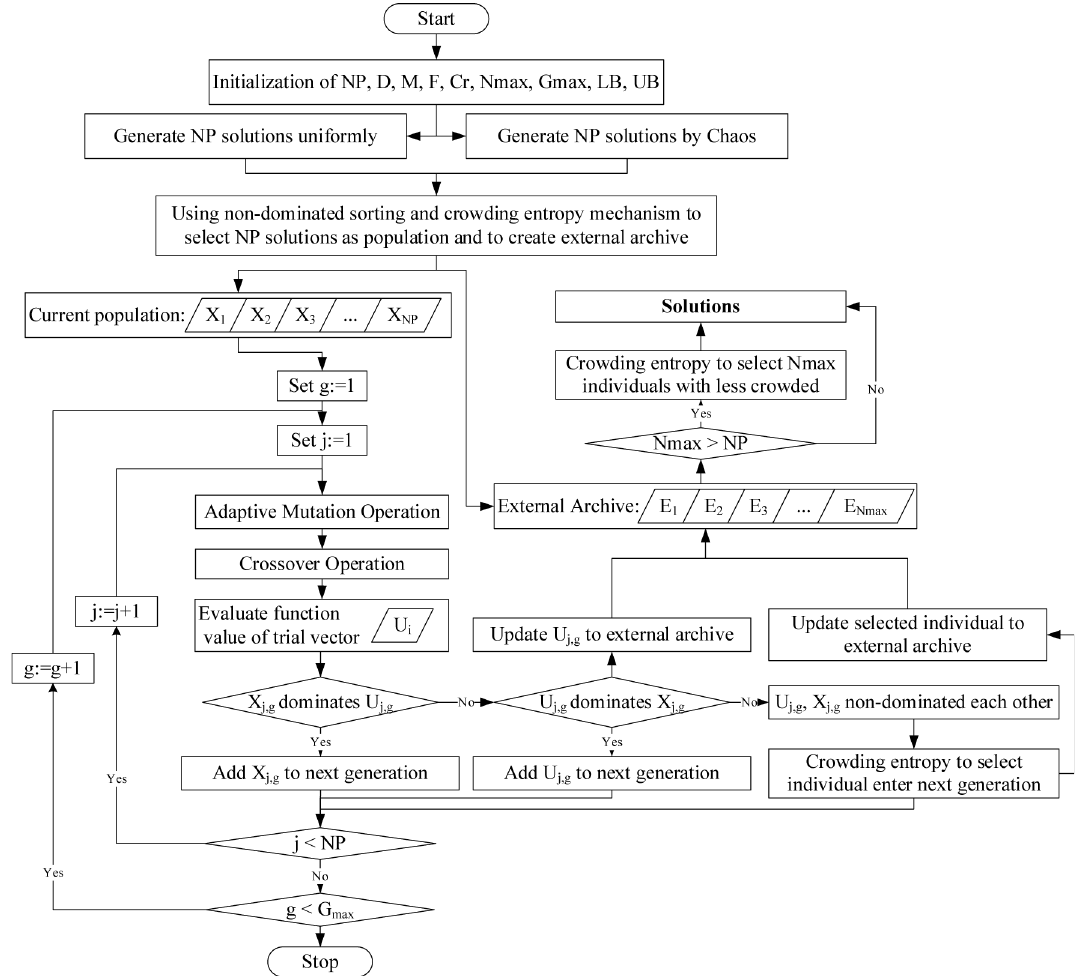
Fig. 1. Flowchart of CA-MODE